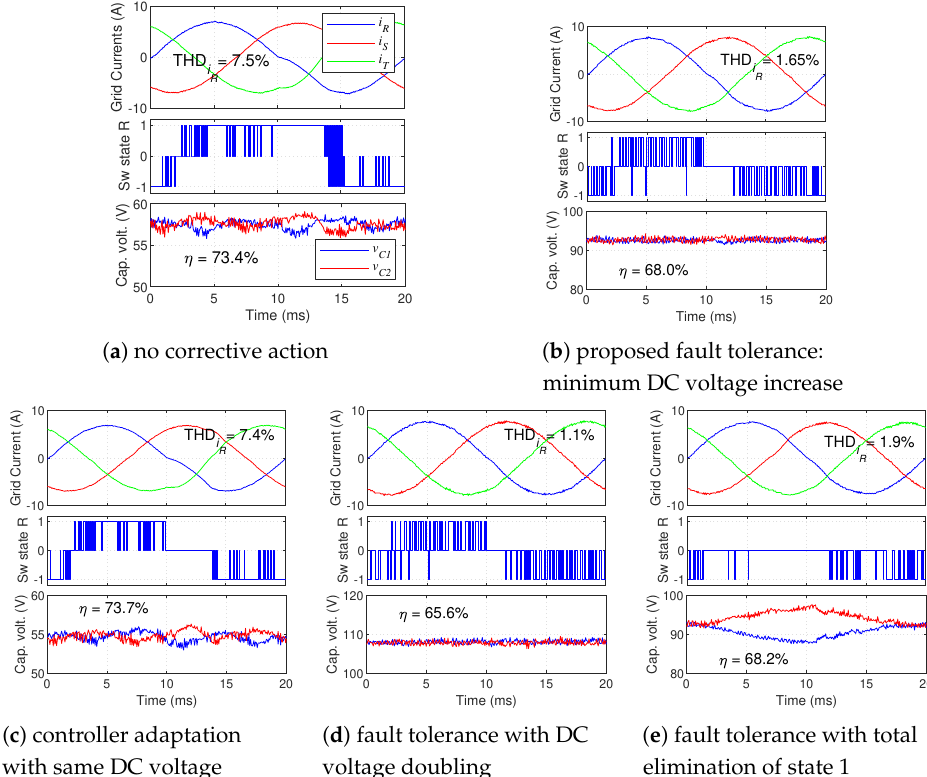
Figure 16. Steady-state GSC operation after a fault in outer IGBT S R 1 , with different corrective